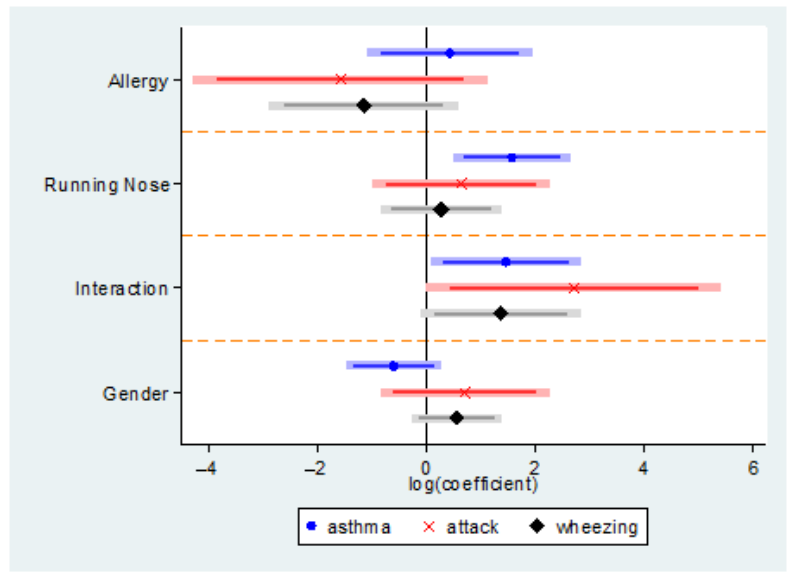
Figure 2. Risk of asthma, asthma attack, and wheezing (without asthma diagnosis) with respect to selected covariates.